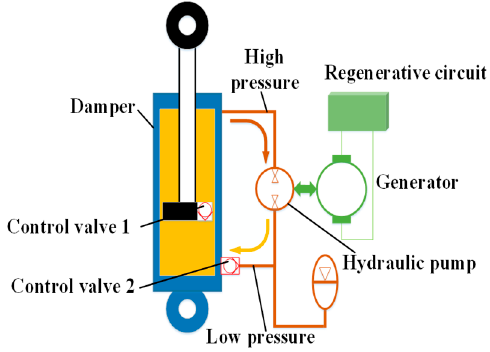
Figure 3. Hydraulic regenerative suspension.